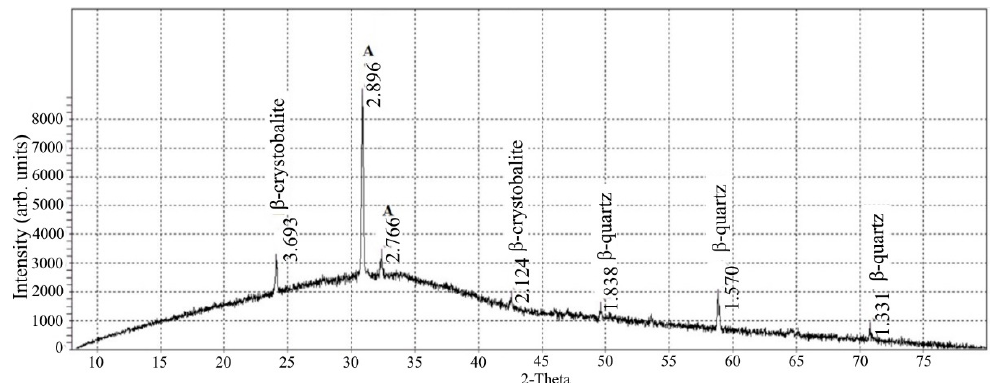
Figure 3. XRD pattern of waste basalt TFM: A—augite Ca(Mg,Fe)Si 2 O 6 or anorthite CaAl 2 Si 2 O 8 . The main crystalline phases of TFM that belong to plagioclases are augite Ca(Mg,Fe)Si 2 O 6 and anorthite CaAl 2 Si 2 O 8 , which is characteristic of crystalline basalt.